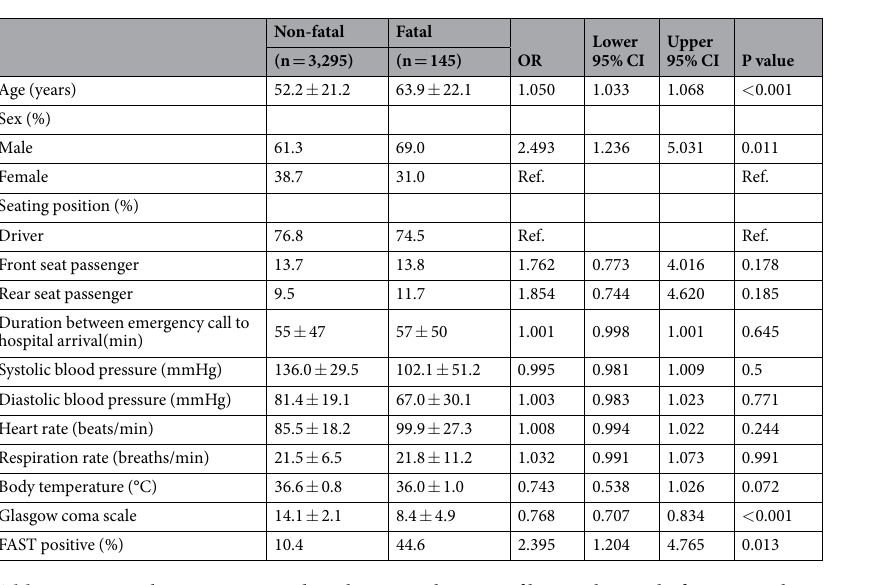
Table 5. Patient characteristics and vital signs at the time of hospital arrival of patients who survived (non- fatal group) versus patients who died (fatal group) during Period B (2016–2017). OR: odds ratio, 95% CI: 95% confidence interval, FAST: focused assessment with sonography for